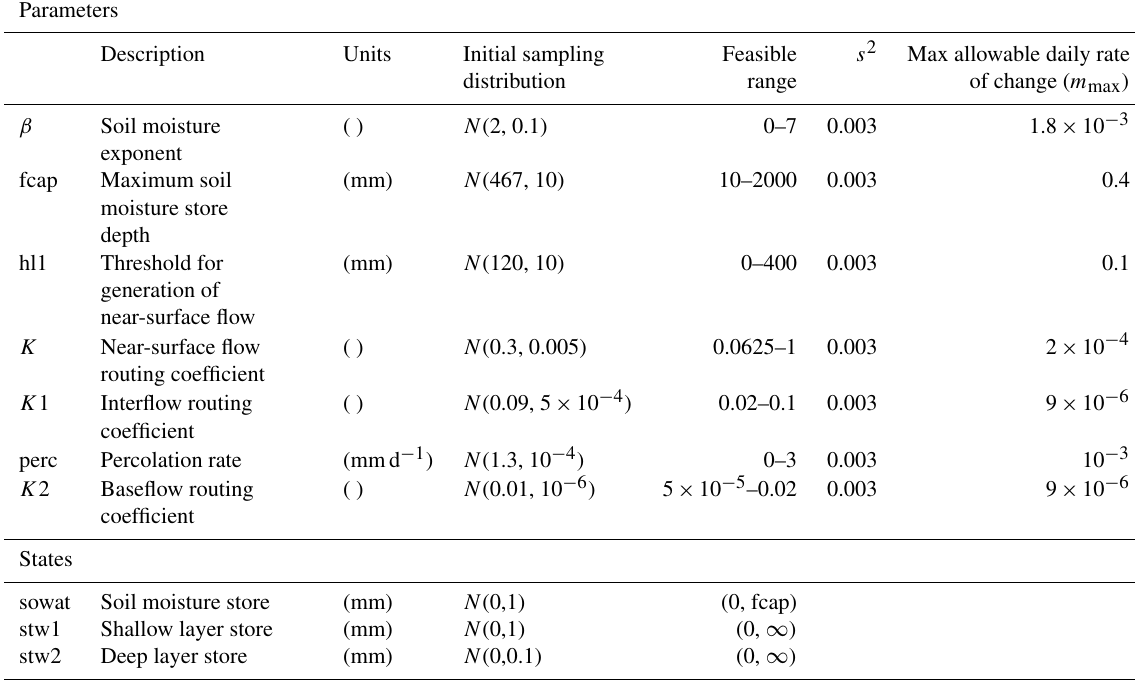
Table 4. LL EnKF inputs for the HBV model